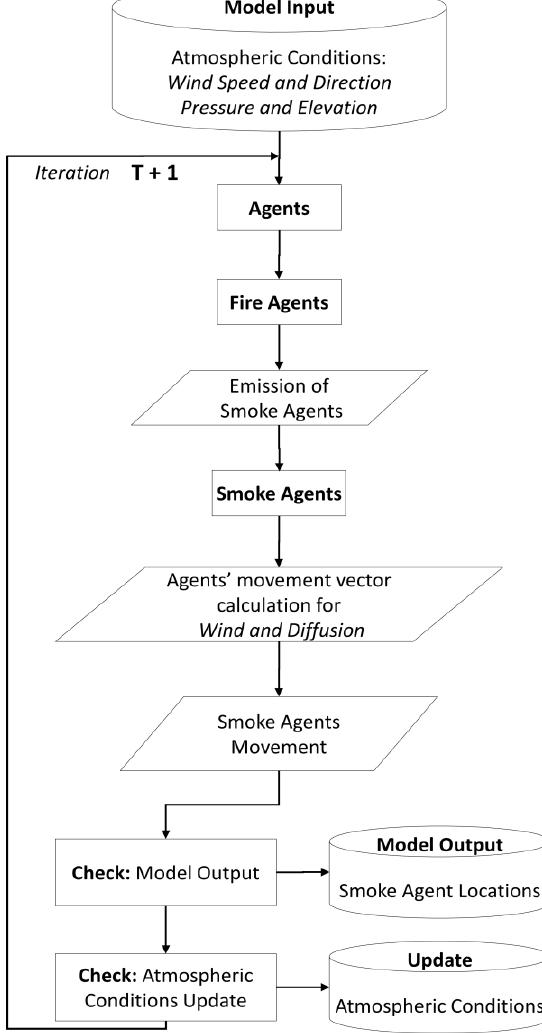
Figure 1 – Flowchart of the agent-based model of forest-fire smoke